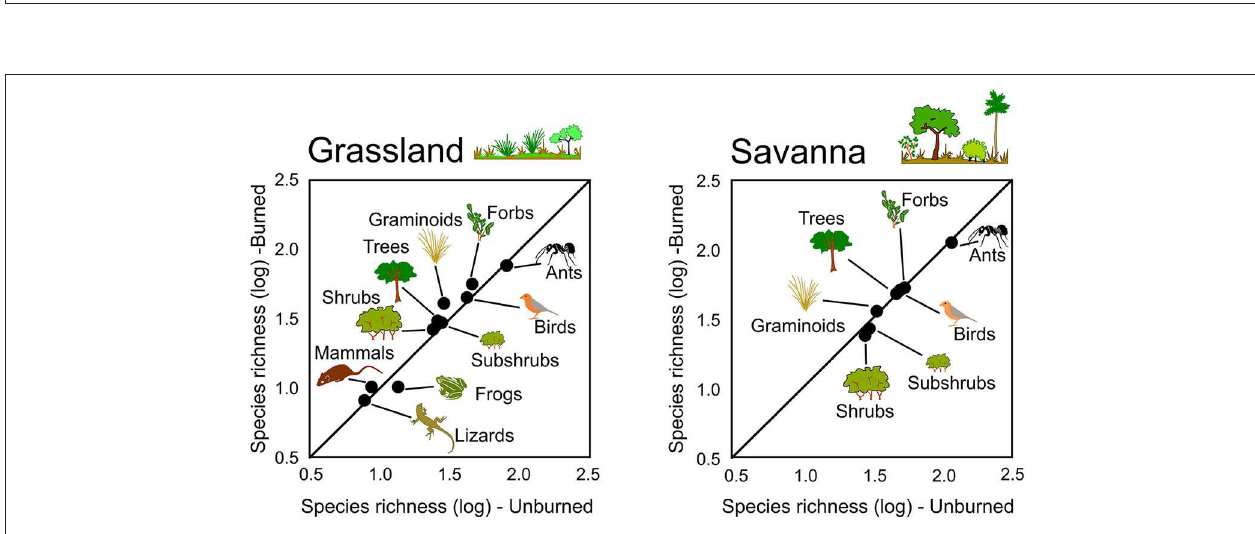
Frontiers in Forests and Global Change |